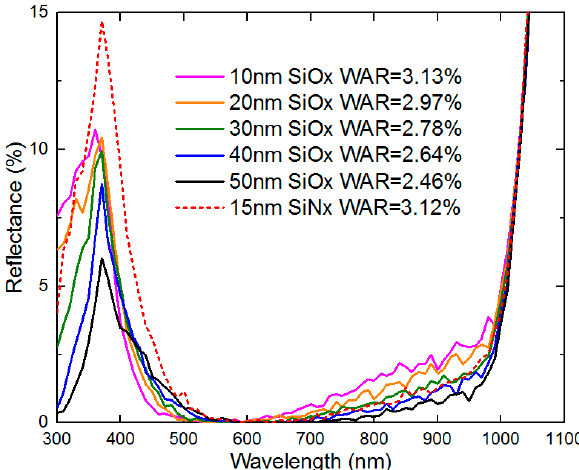
Figure 3. The simulated reflectance curves of monocrystalline silicon PERC solar cells with different third layers of antireflection coating in SunSolve. The corresponding weighted average reflectances ( WARs ) are listed.